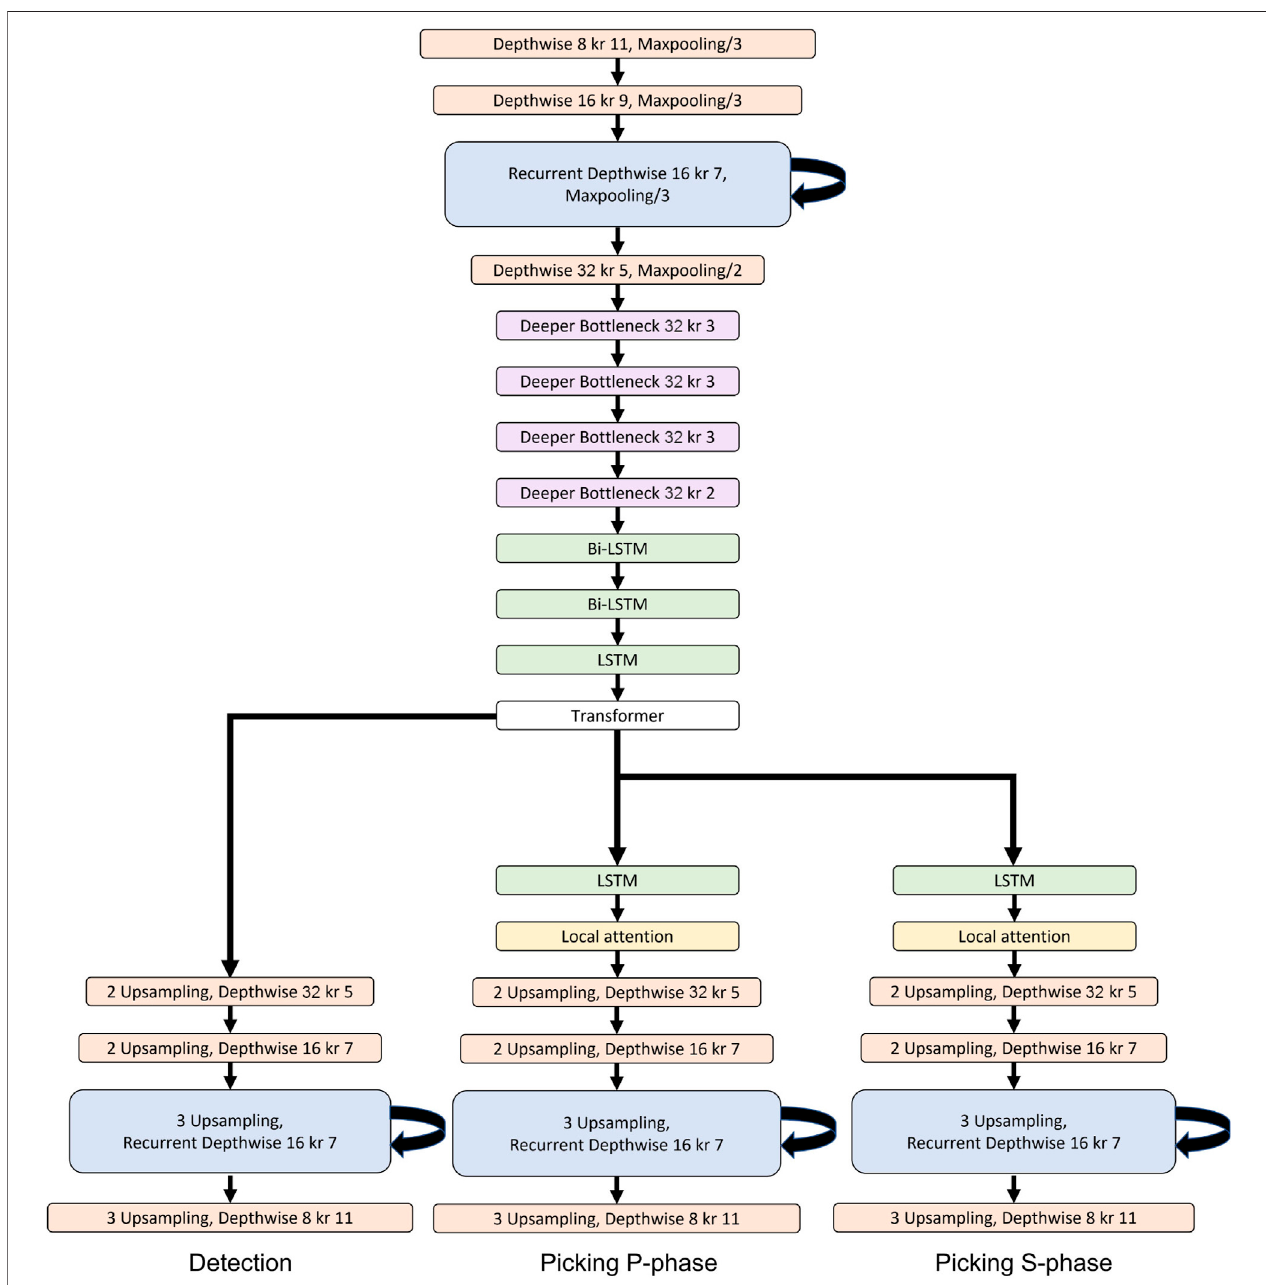
FIGURE 3 | LEQNet model architecture. Depthwise separable CNN and recurrent CNN were applied to the encoder and decoder, respectively. The number of layers in the encoder was reduced to fi ve, while the EQTransformer had seven layers in the encoder. Features can be extracted via four blocks using deeper bottleneck and via fi veblocksintheEQTransformer.DetaileddescriptionofeachblockisprovidedintheMethodssection.Theconvolutionallayersrepresentthenumberofkernels, and kr is the kernel size.